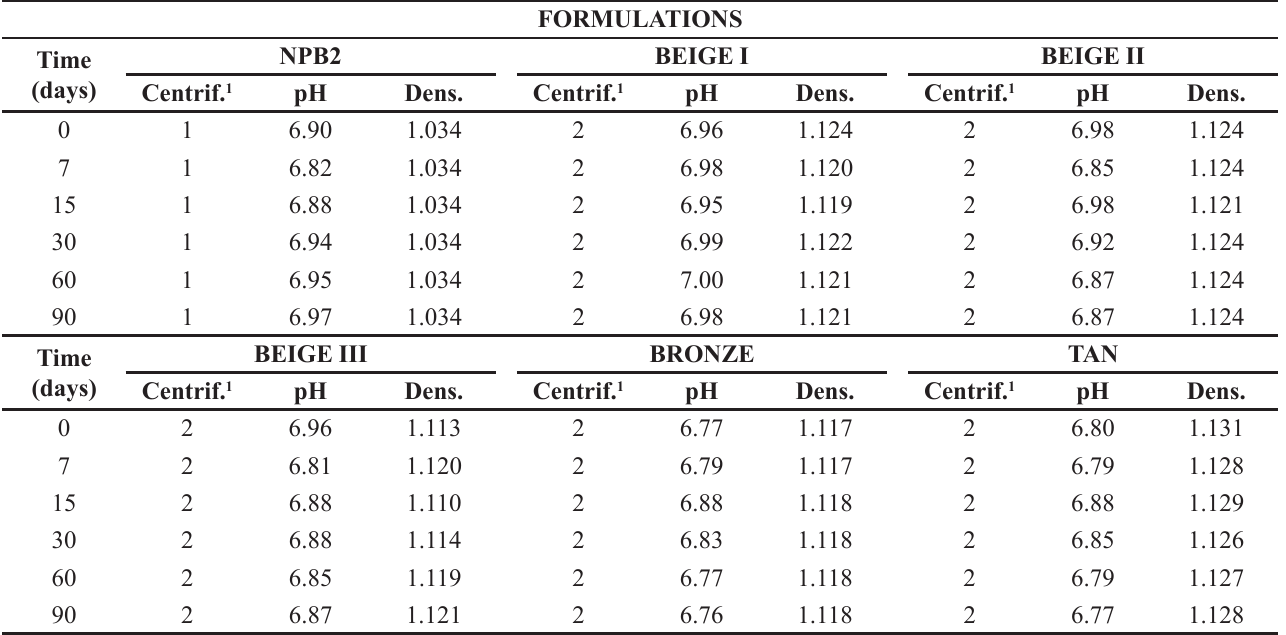
TABLE X - Results of centrifugation tests (Centrif.), pH and density (Dens.) of the NPB2 base and corrective makeup stored at room temperature (23.0 ± 2.0 ºC) for up to 90